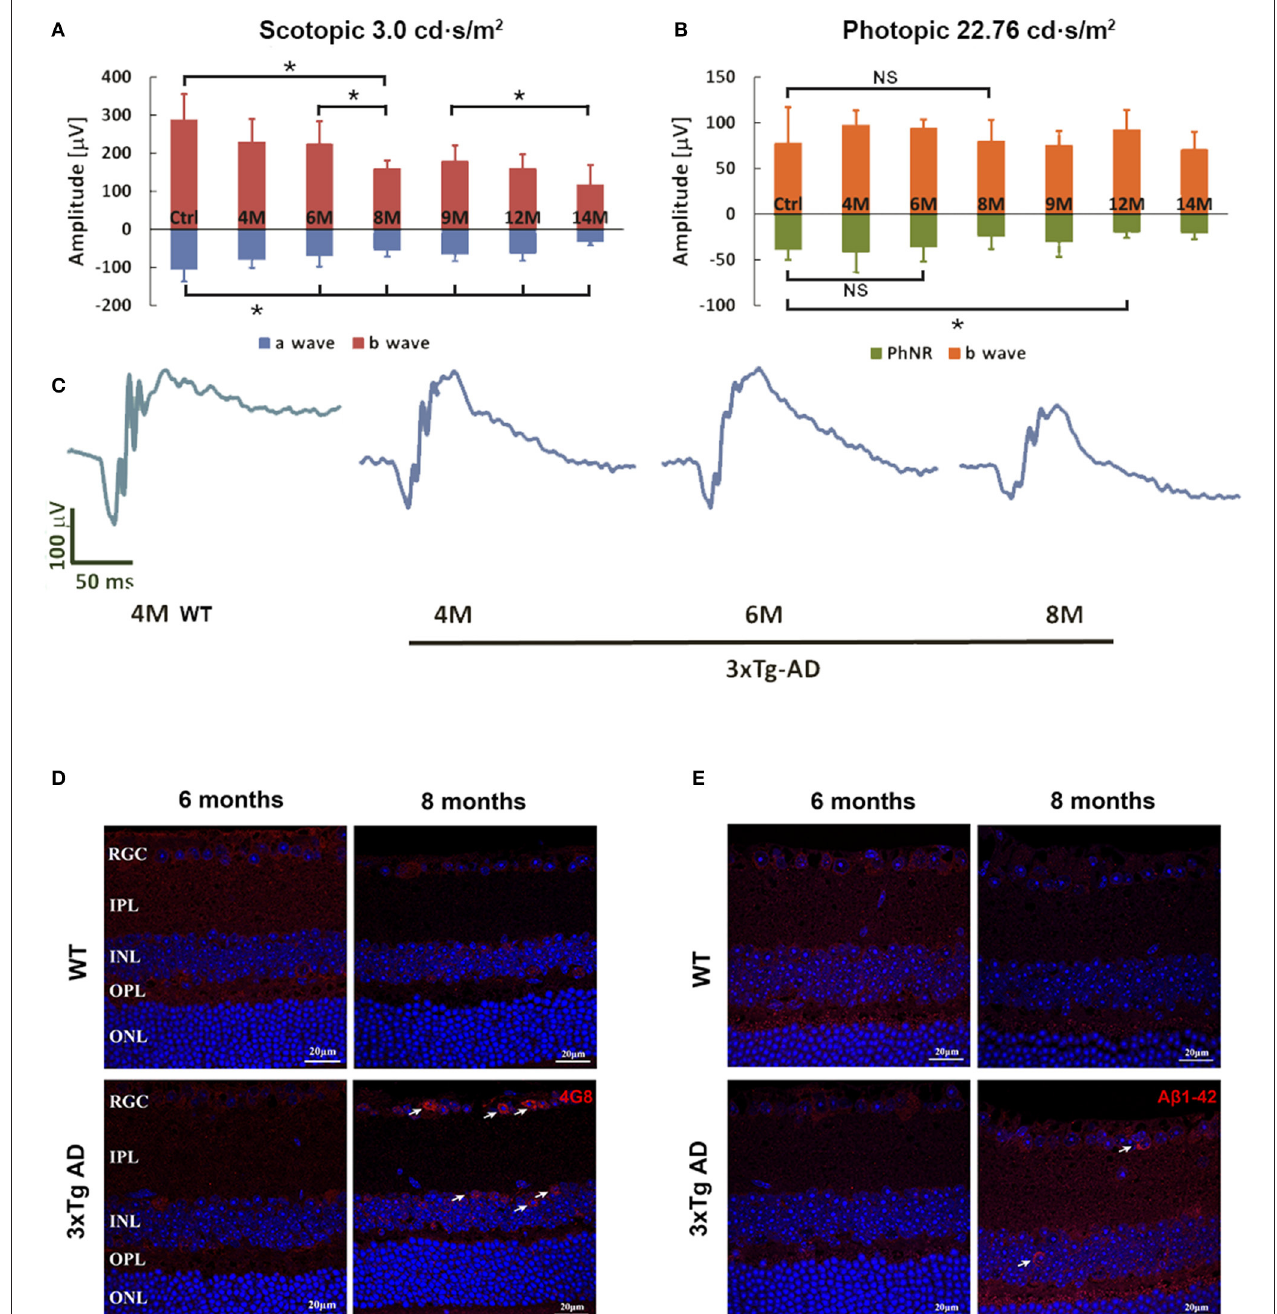
FIGURE 1 | Flash-ERG and amyloid beta (A β ) deposition in retinas of non-Tg control mice and 3xTg-AD mice at different ages. The scotopic retinal response (A) of 3xTg-AD mice started to decline at 6 months of age, followed by a rapid decrease from 6 to 8 months of age (A,C) . * p < 0.05. Further significant decline in b wave changes can be detected between 6–8 months and 9–14 months. Significant reduction in a wave started at 6 months when compared with non-Tg controls. PhNR detected in the photopic response revealed a significant reduction at 12 months when compared with non-Tg controls (B) . * p < 0.05; NS, no significant change. Typical ERG wave forms are shown in C. Intracellular A β deposition of 4G8 (D) and A β 1-42 (E) were detected in the RGCL and INL of retinas of 3xTg-AD mice at 8 months only (arrows). No positive signal could be detected in the non-Tg controls or 6 month old 3xTg-AD retinas. Scale bar: 20 µ m.